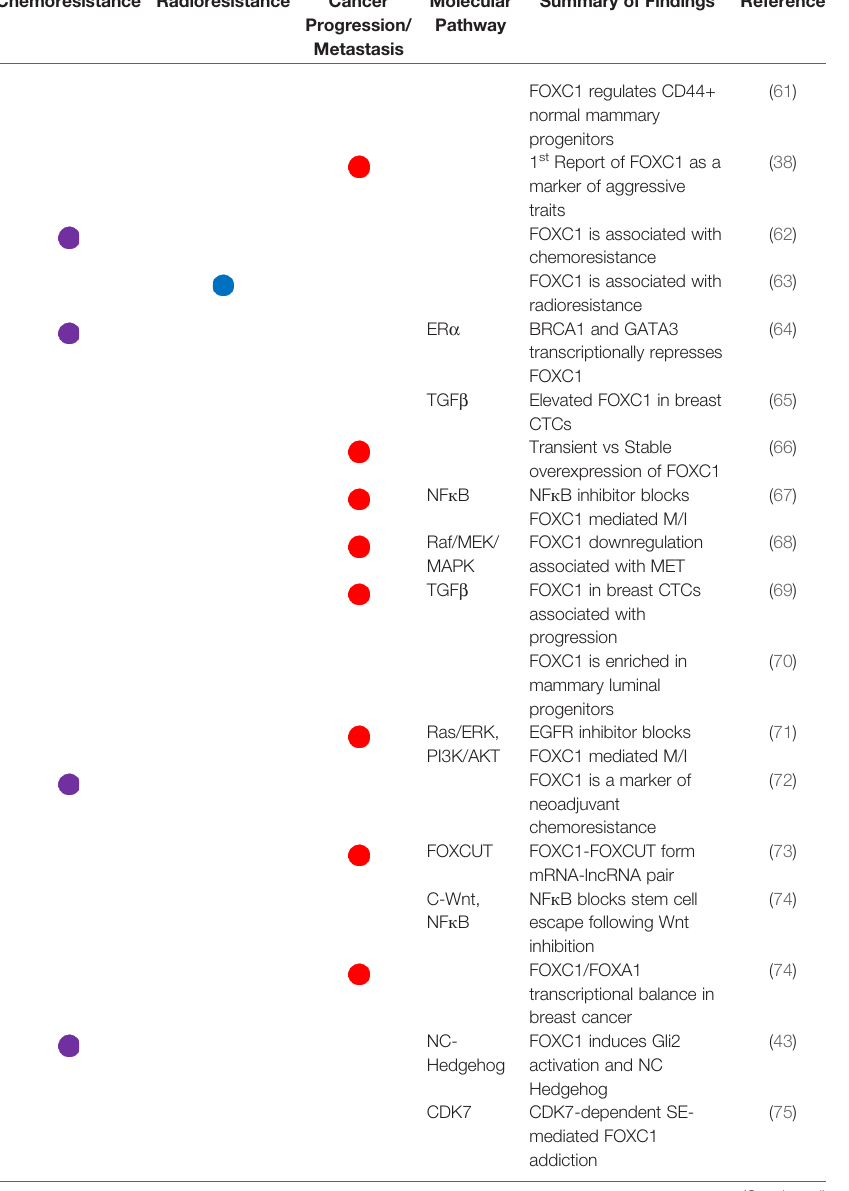
TABLE 2 | Functional and mechanistic evidence supporting role of FOXC1 in plasticity, EMT, chemoresistance, cancer progression and metastasis. Cancer